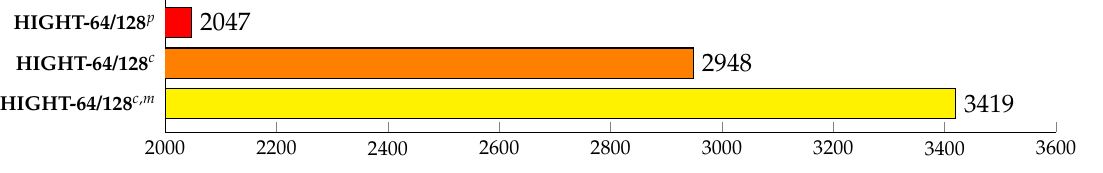
Figure 20. Comparison of throughput (MB/s) for HIGHT implementations on GPU platform including memory copy time, where p , c , and m represent parallel ECB mode of operation, parallel CTR mode of operation, and GPU memory optimization, respectively.(HIGHT-n/m means n-bit plaintext encryption with the m-bit key).